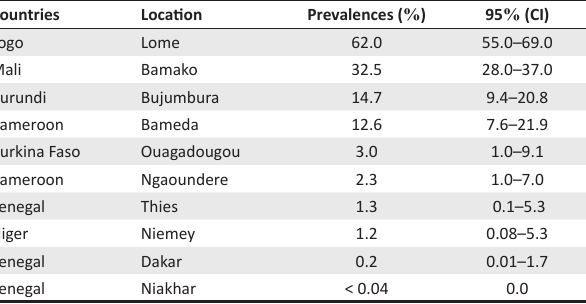
TABLE 1: Brucellosis prevalences in peri-urban dairy herds in Western and Central African countries.